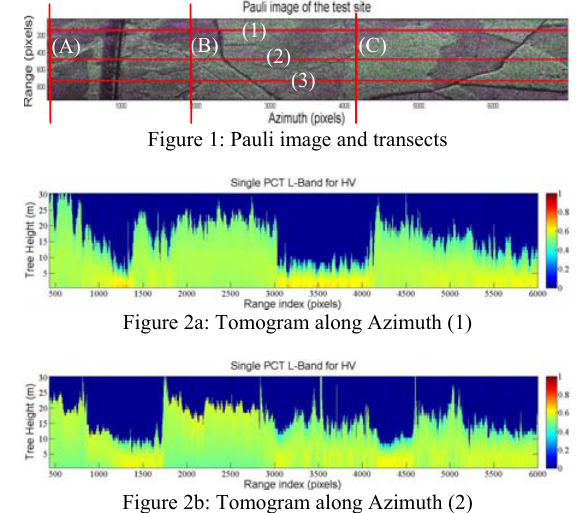
Table 1: Design parameters of Intermap technologies’ L-Band fully polarimetric InSAR radar system.